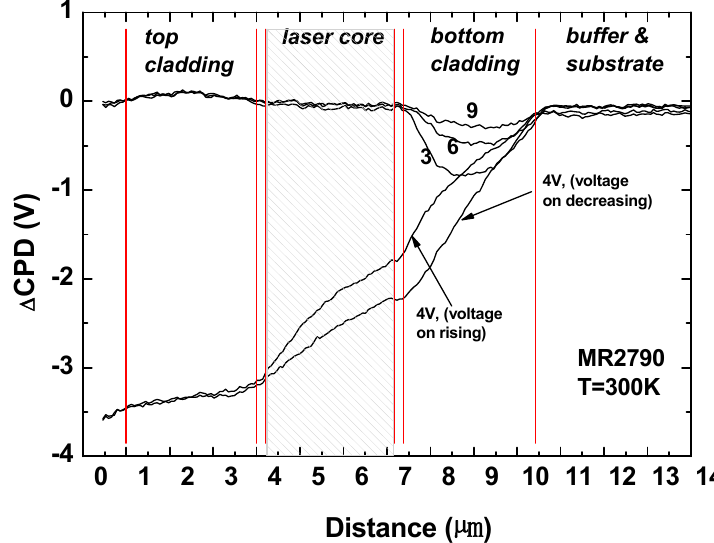
Figure 4. Contact potential di ff erence profiles for the GaAs-based QCL with AlInP claddings measured on the cleaved laser facet by the KPFM technique. The observed hysteresis (the voltage was increased from 0 to 4 V for the first measurement and the voltage was decreased from 7 to 4 V for the second one) and a very slow time dependence (measured in 3, 6 and 9 minutes) after switch-o ff might indicate the existence of charge that has accumulated around the bottom AlInP cladding.